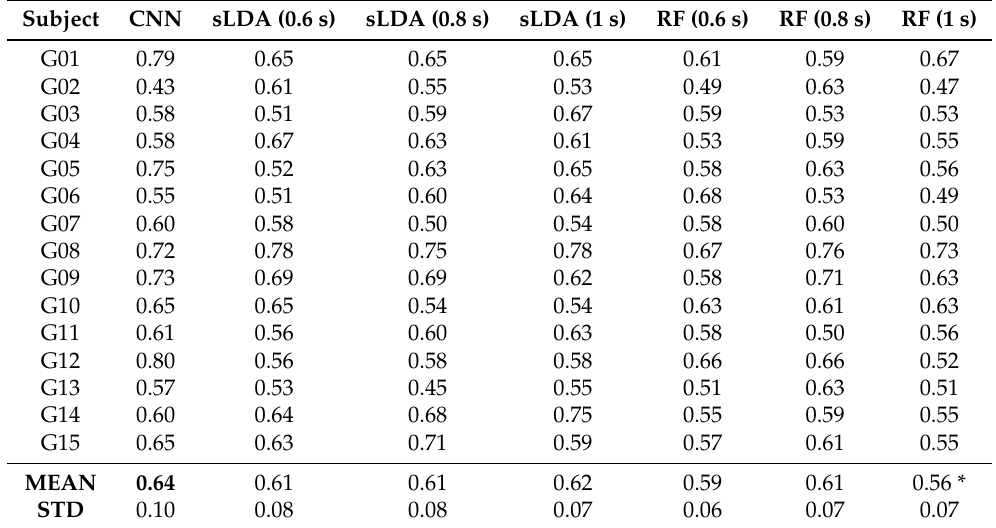
Table 2. Comparison of classification performance (in terms of accuracy) in validation from Dataset 2